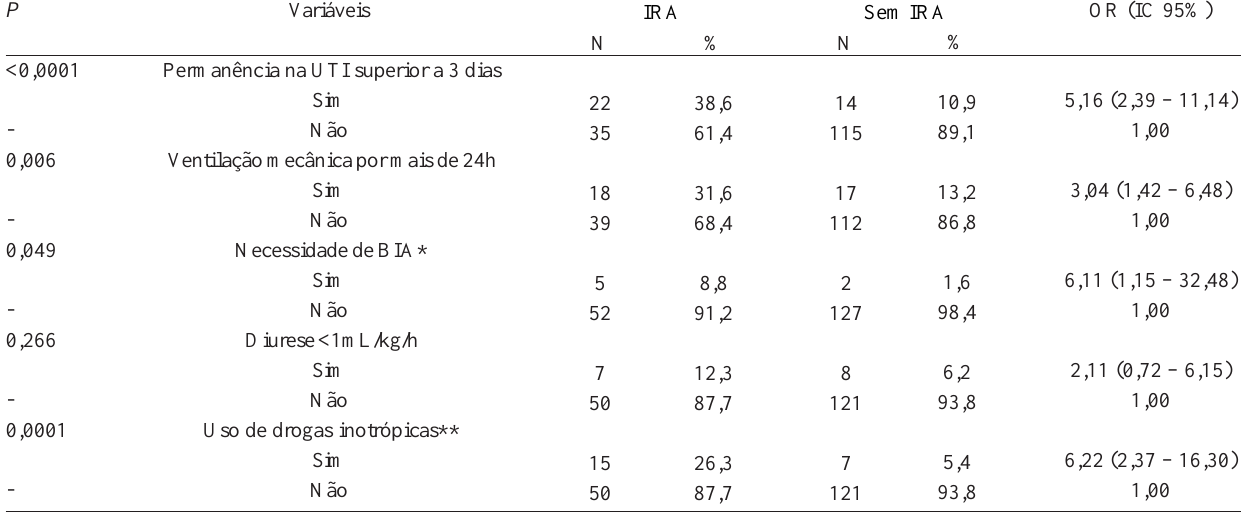
Tabela 4. Intercorrências pós-operatórias em pacientes com e sem IRA submetidos à cirurgia de revascularização do miocárdio. Variáveis